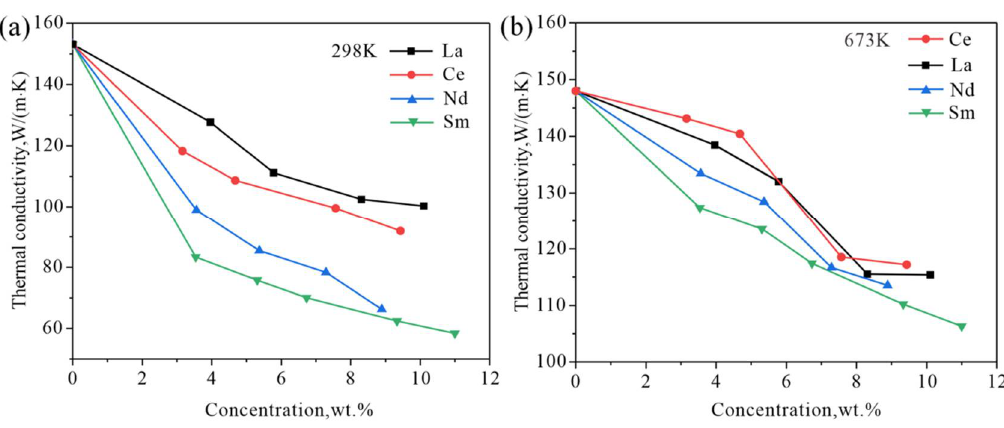
Figure 10. Effect of alloying elements addition on thermal conductivity of ( a ) as-cast magnesium alloys at 298 K; ( b ) annealed magnesium alloys at 673 K.